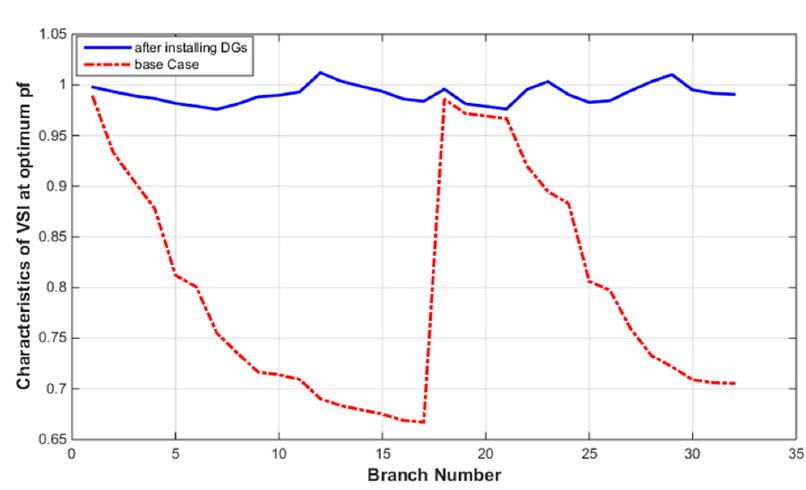
Figure 19. Characteristics of VSI, 33-bus system at optimum pf.